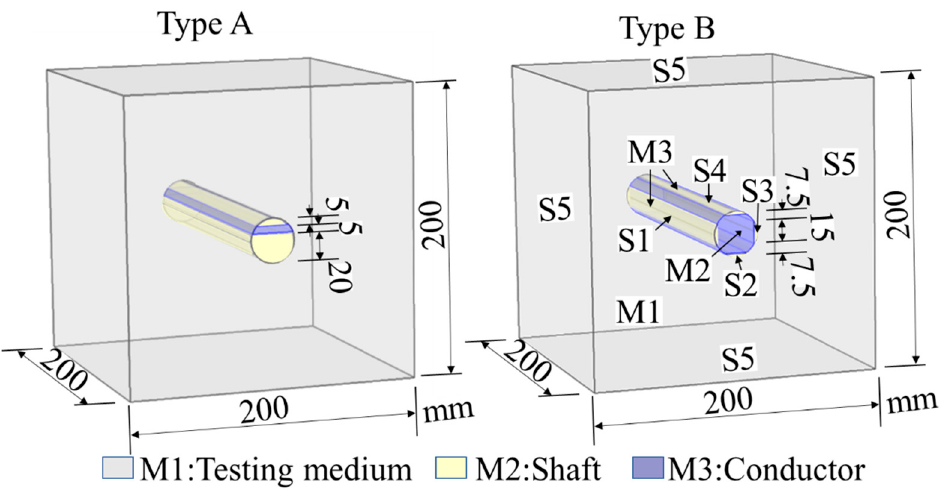
Figure 2. Transparent view of 3D numerical model for computing the electrical potential field surrounding the type A and B TDR probes comprised of the nonconductor shaft and conductors. For the type B probe, M1 and M2 represent the testing medium and shaft material, and M3 involves the four conductors. S1, S2, S3, and S4 represent the lateral boundaries of the four conductors (M3), respectively. S5 represents the lateral boundaries of the testing medium. The unit of the dimensions of the model is mm.